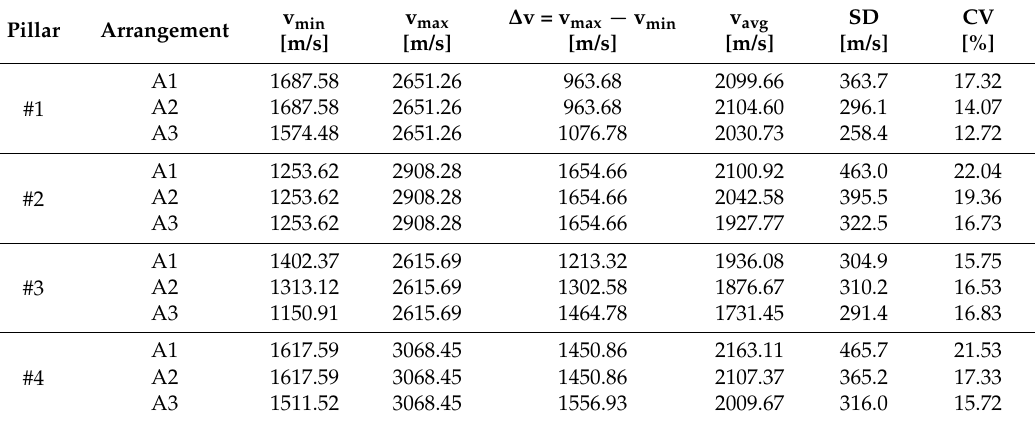
Table 5. Experimental wave propagation velocities for configuration #A.